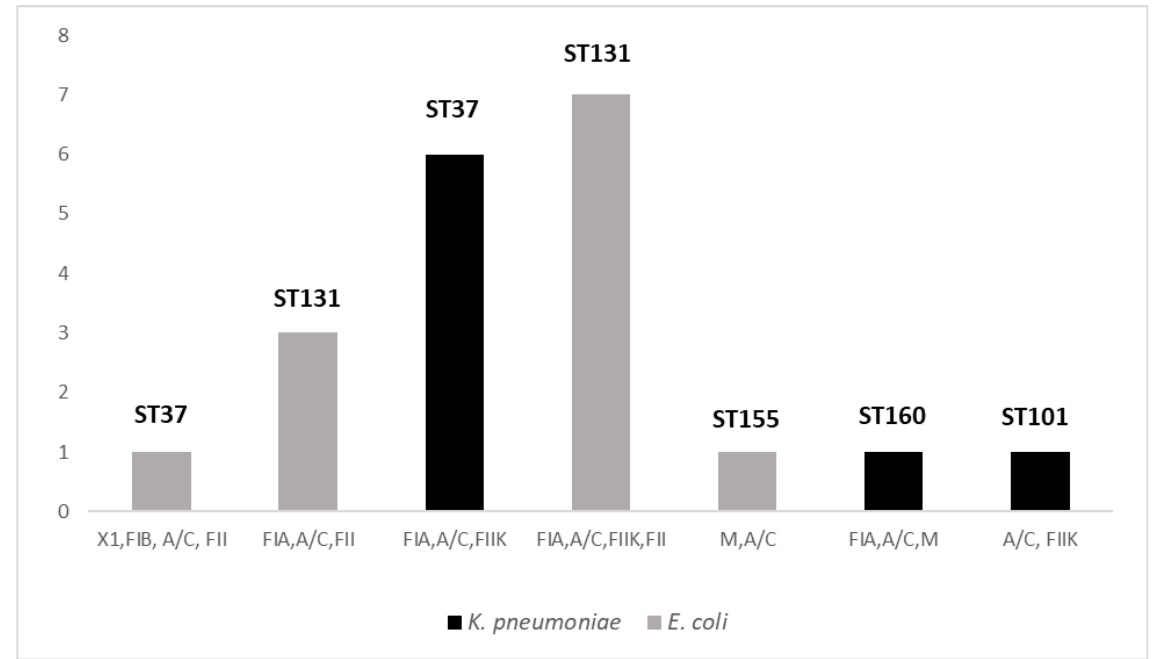
Figure 2. Distribution of replicon profiles and STs among collected strains of K. pneumoniae and E. coli . Seven replicons profiles were distributed among 20 CPE strains and all were associated with a single species. Five PBRT profiles were composed by three or more Inc groups. Both in K. pneumoniae and in E. coli strains, two replicon patterns were associated with the same prevalent ST (ST37 and ST131 in K. pneumoniae and in E. coli , respectively).